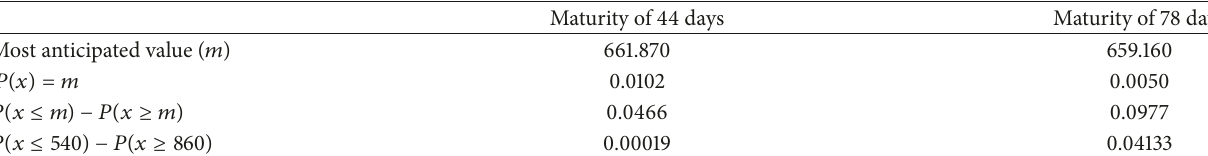
Figure 1: RND 3 July 2012 extracted from S&P TSX 60 index. Table 1: Maturity effect on traders’